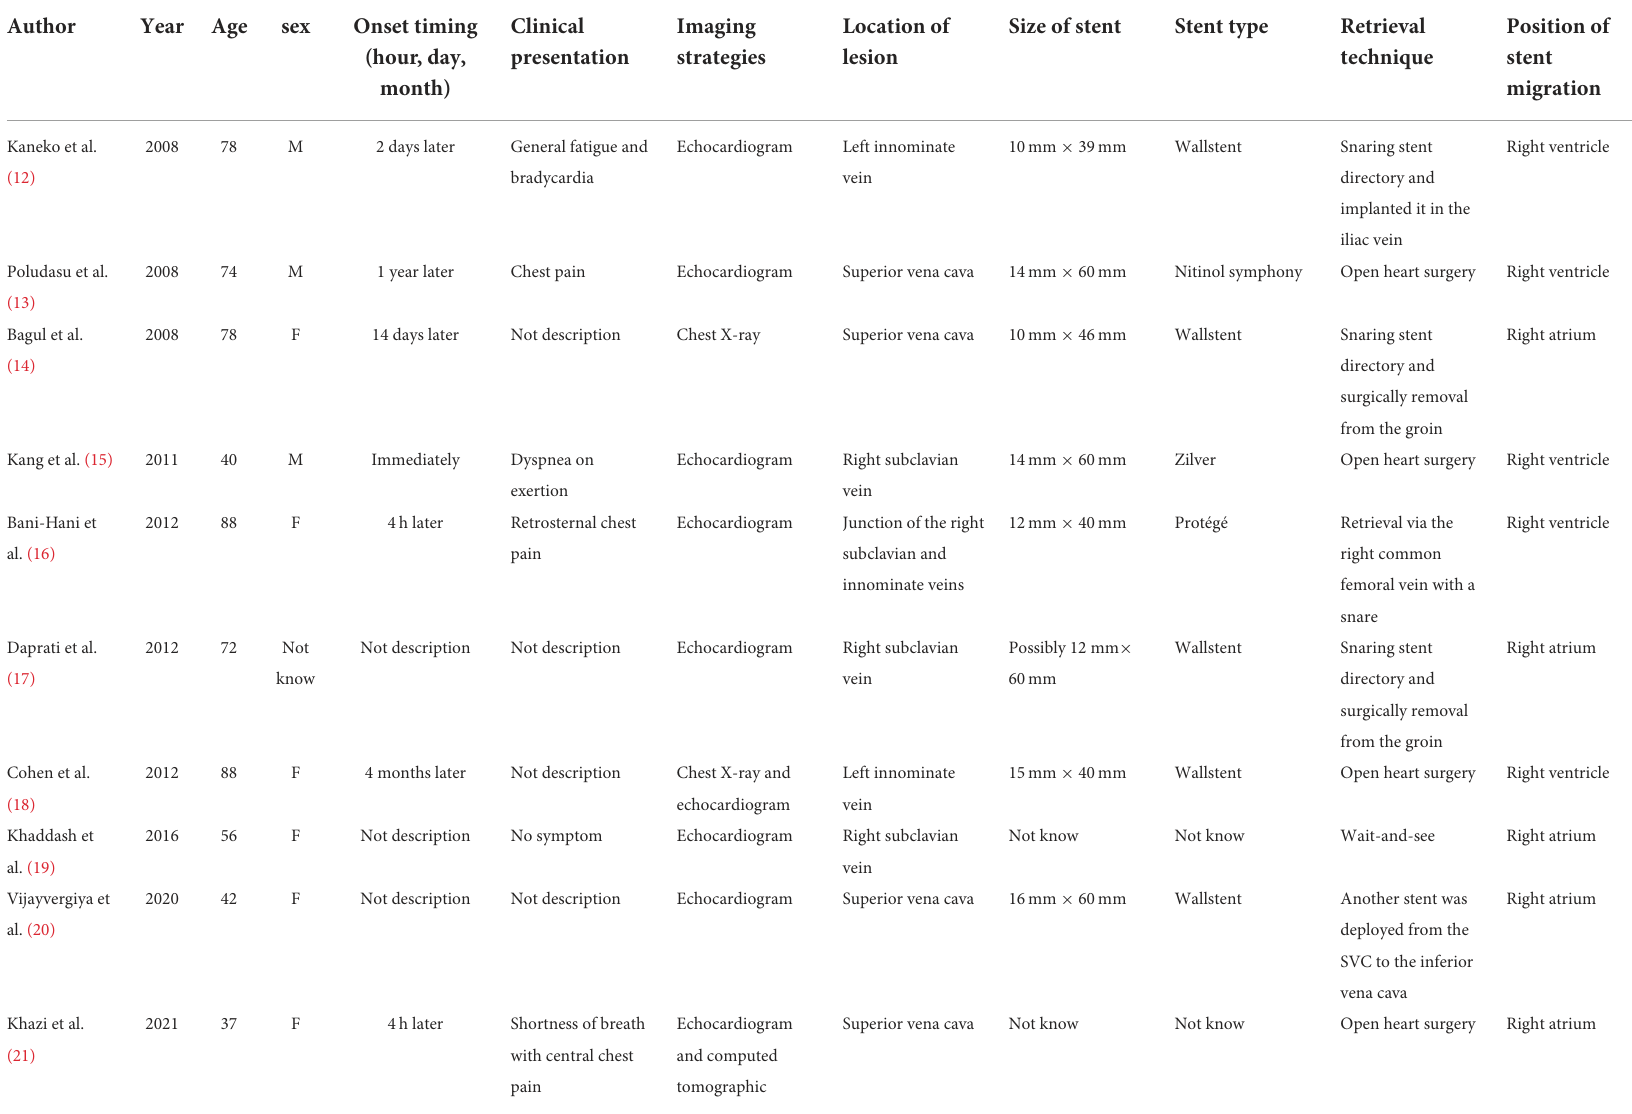
TABLE 1 Clinical and technical aspects of 11 patients with misplaced or dislodged stents in the cardiac chambers.